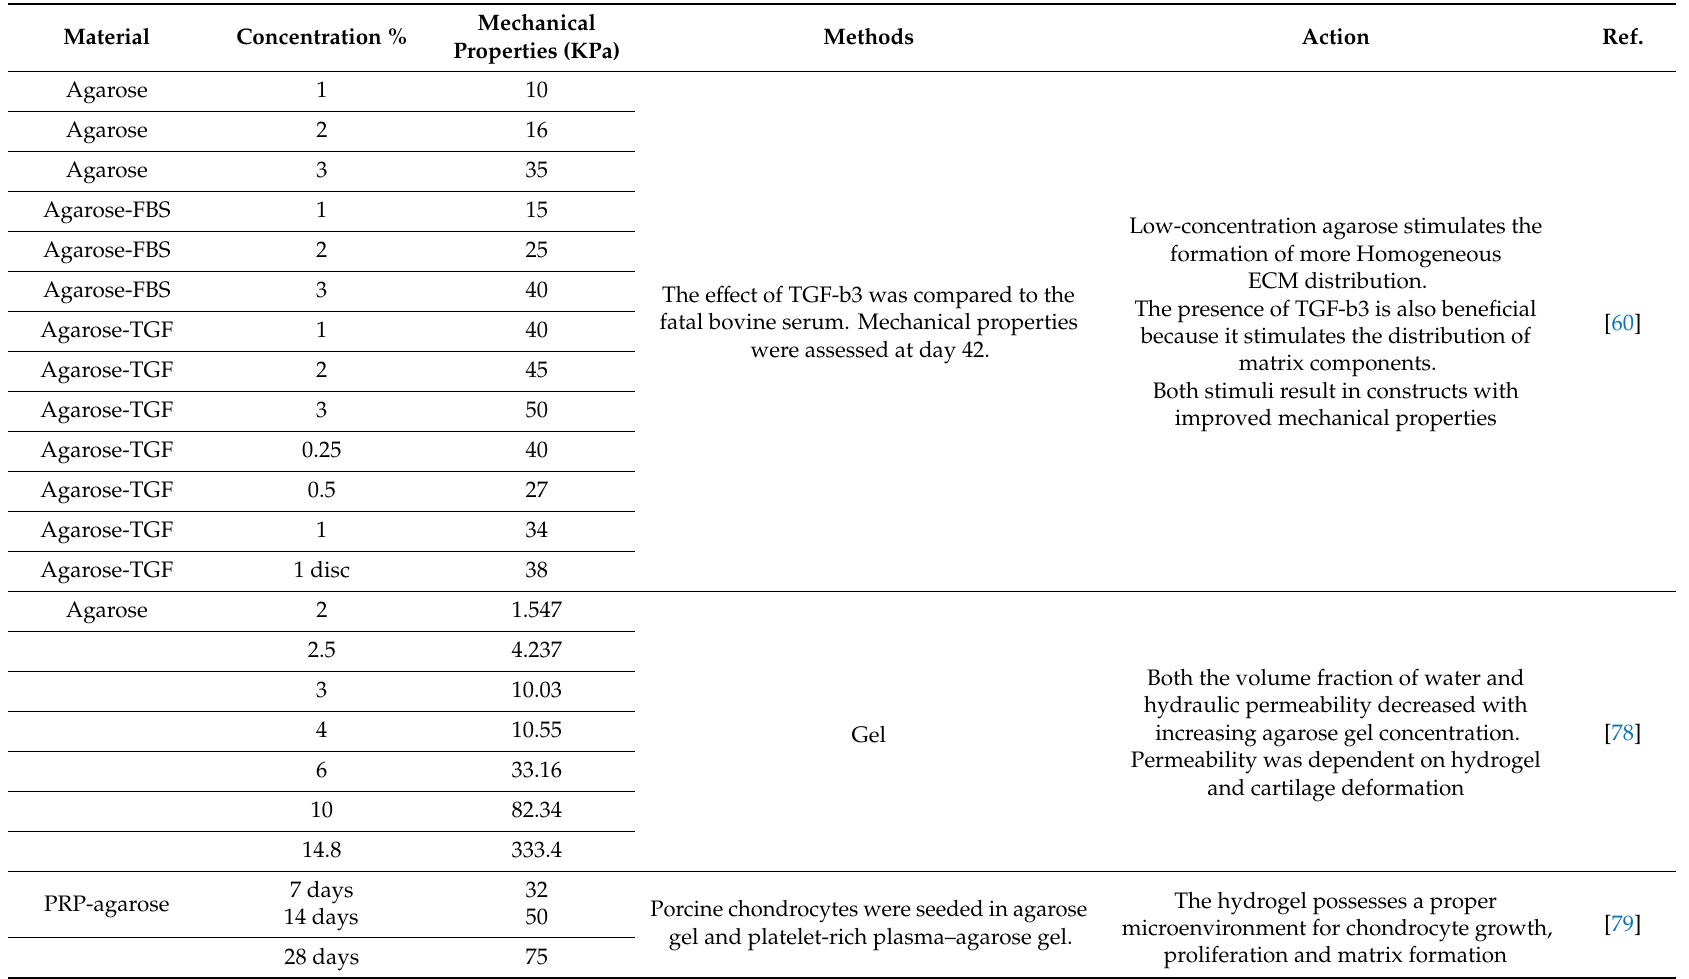
Table 3. A brief view at the mechanical properties, concentrations, and the methods of applications of agarose-based biomaterials in biomedical applications. Mechanical Material Concentration % Methods Action Ref. Properties (KPa) Agarose 1 10